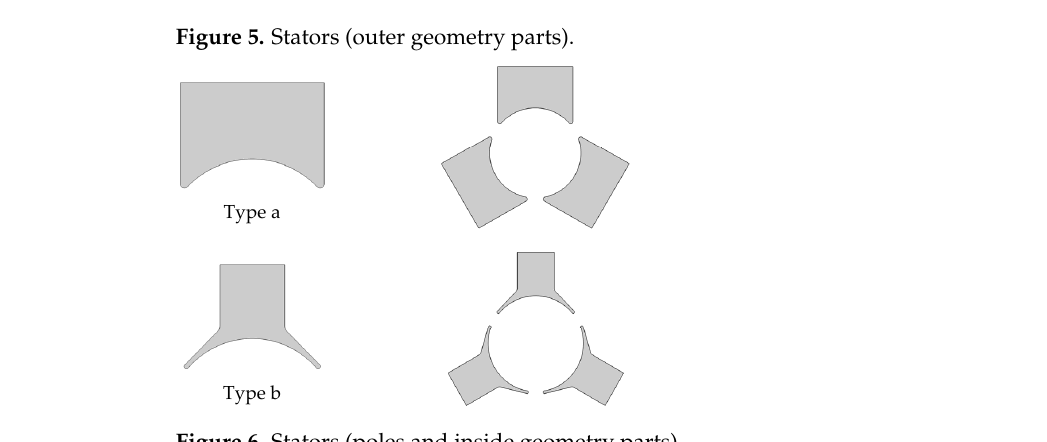
Figure 6. Stators (poles and inside geometry parts).